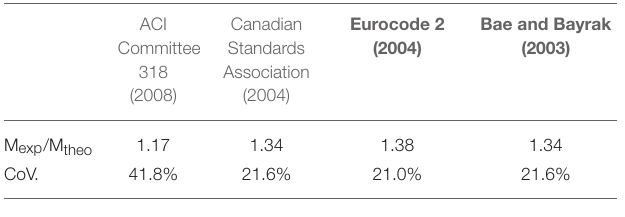
TABLE 2 | Flexural strength